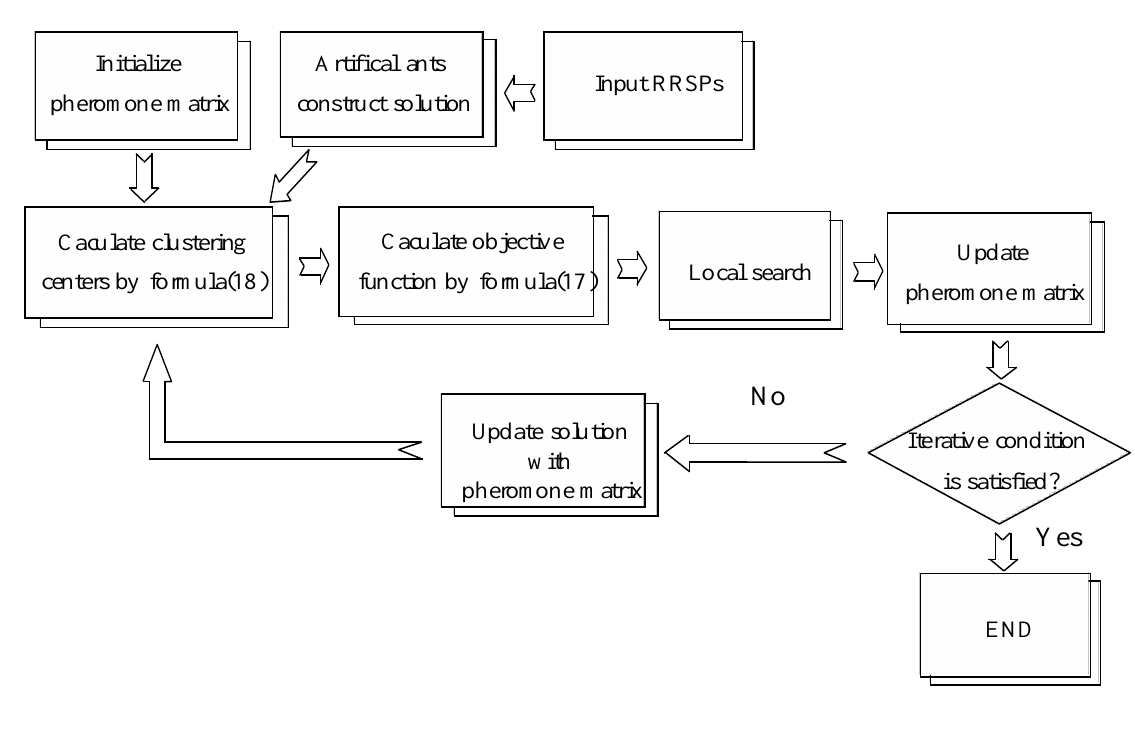
Figure 2. Flowchart of ACO for condition